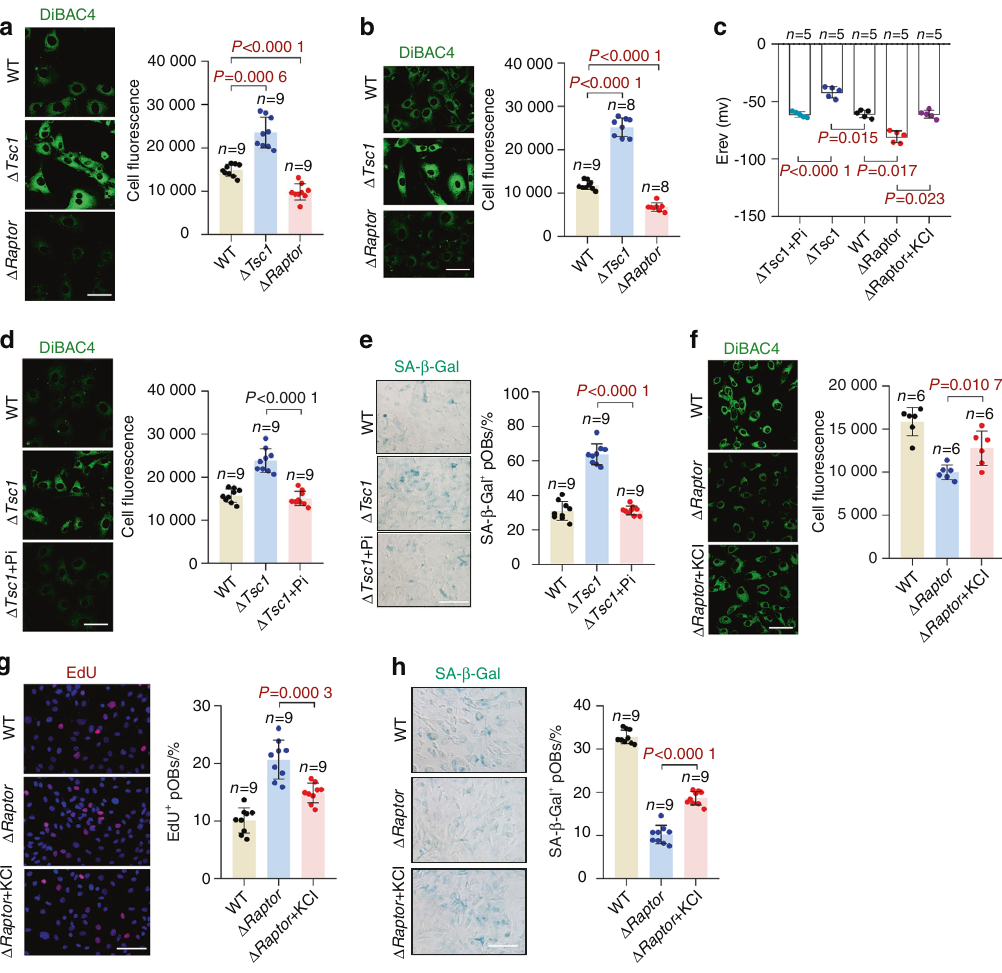
Fig. 5 Plasma membrane depolarization contributes to preosteoblast senescence. Senescent wild-type (WT), Δ Tsc1 , and Δ Raptor preosteoblasts isolated from calvaria ( a ) or long bones ( b ) were incubated with fl uorescent DiBAC4 dye and photographed under a confocal microscope. Scale bars, 50 μ m. Cell fl uorescence was measured as the mean corrected total cell fl uorescence (CTCF) of all the cells in nine different images taken at ×400 magni fi cation in ImageJ. Depolarization is indicated by increased fl uorescence. c Histograms showing the mean reversal potentials (E rev ) of ramp membrane currents determined by the patch-clamp technique in the different indicated preosteoblasts. d Representative confocal images of DiBAC4 fl uorescence in the senescent Δ Tsc1 preosteoblasts treated with pinacidil (Pi). Scale bar, 50 μ m. The fl uorescence intensity of the cells was measured. e SA- β -gal staining of the cells in d and quanti fi cation of the proportion of SA- β -gal-positive cells in each population. Scale bar, 100 μ m. f DiBAC4 fl uorescence in the senescent Δ Raptor preosteoblasts treated with KCl. Relative plasma membrane potentials were measured. g Immunostaining of EdU in the cells in f and quantitative analysis of EdU + cells relative to total cells. Scale bar, 100 μ m. h SA- β -gal staining of the cells in f and quanti fi cation of the proportion of SA- β -gal-positive cells. Scale bar, 100 μ m. Data are shown as the mean ± SD. The numbers of samples ( n ) are indicated in each fi gure panel. P values were determined by two-tailed Student ’ s t test for single